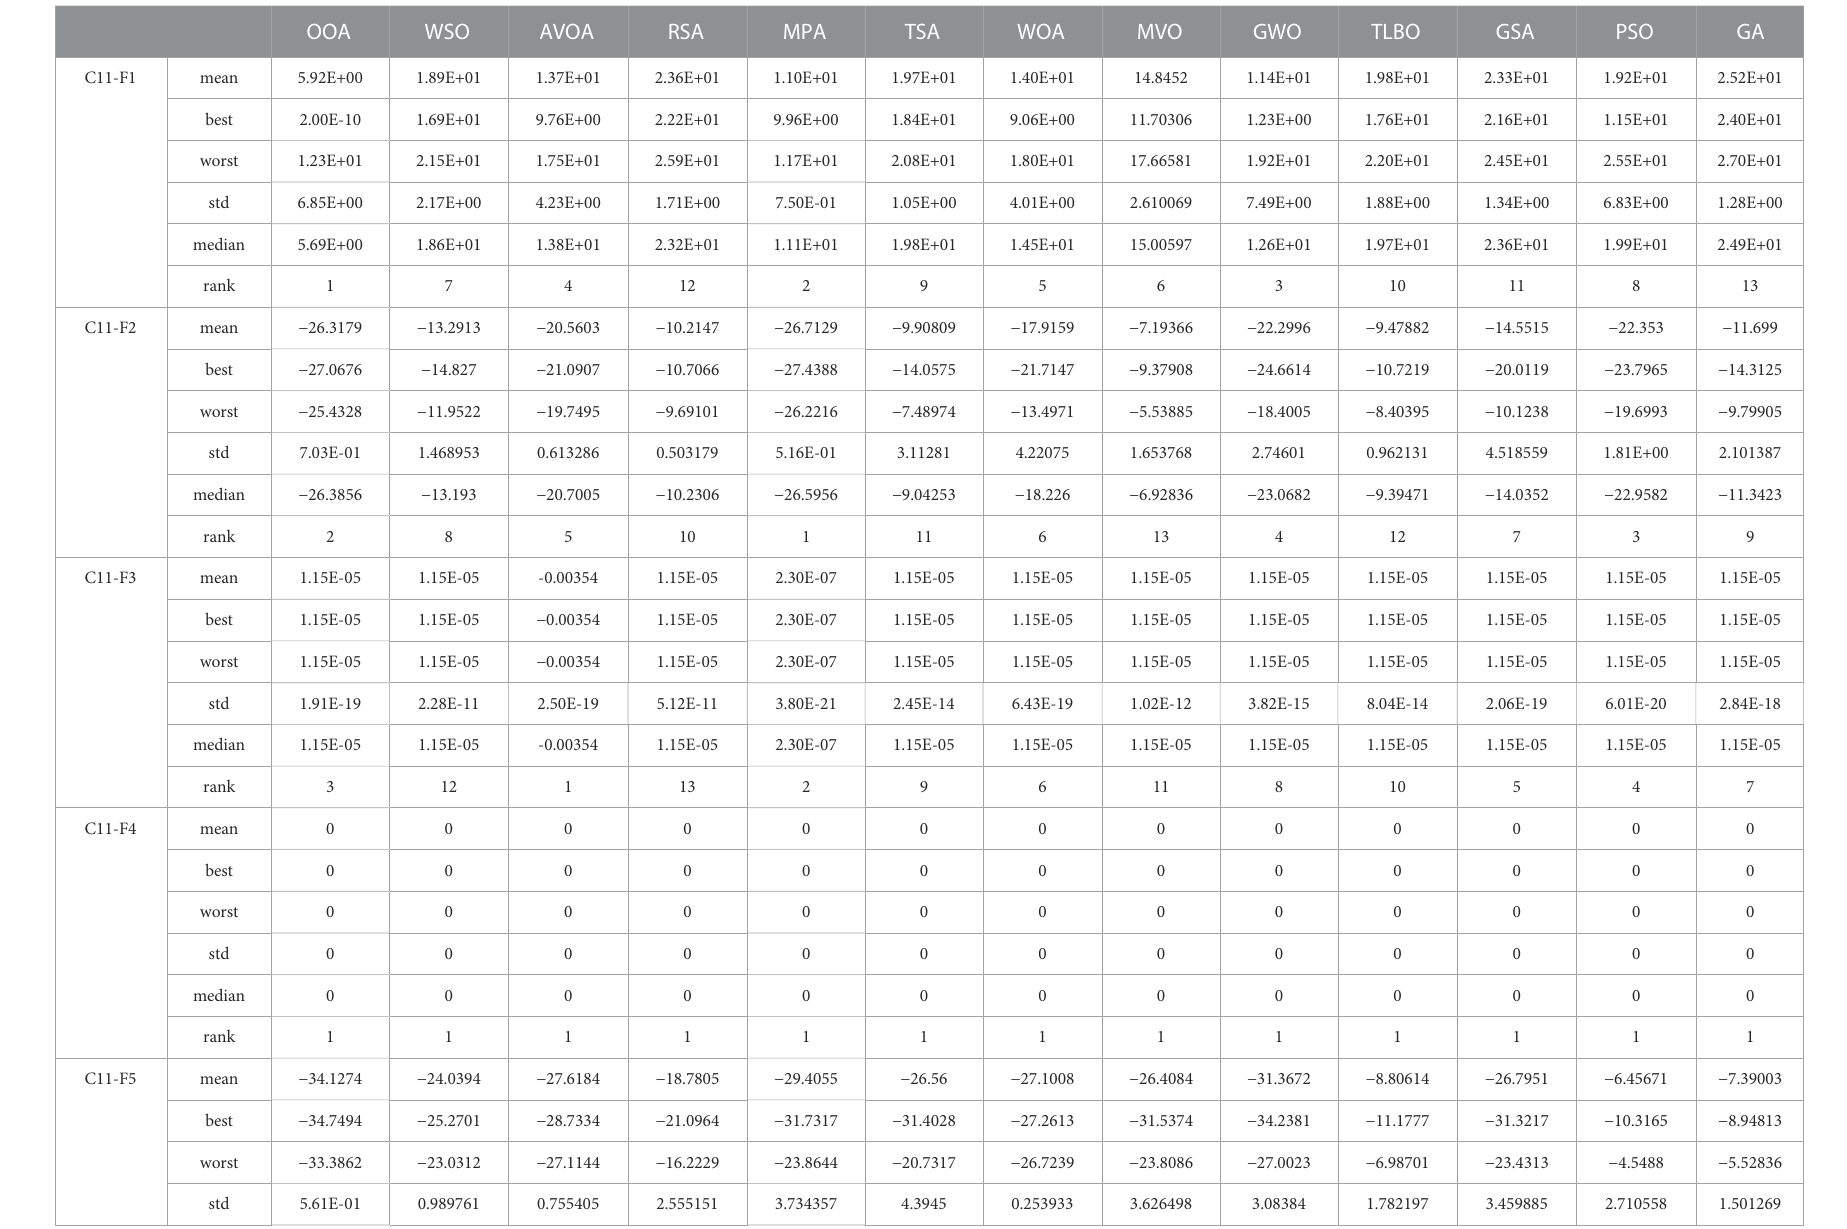
TABLE 7 Performance of optimization algorithms on the CEC 2011 test